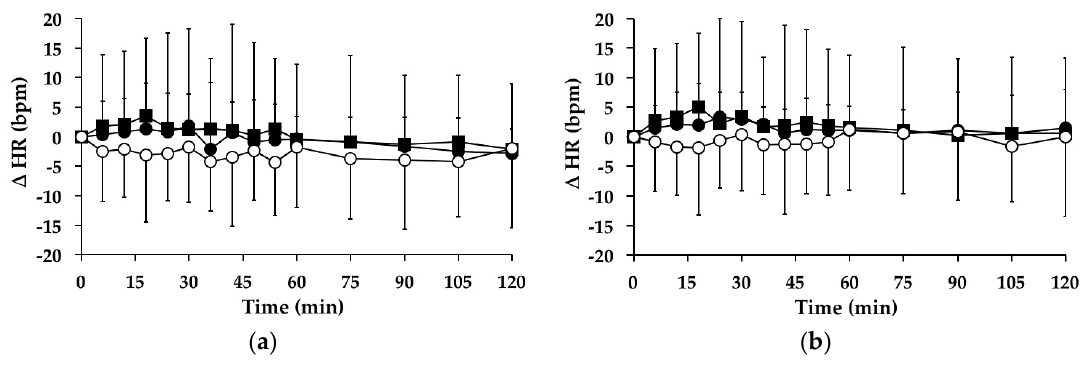
Figure 2. Mean change ( ) in heart rate (HR) on “G” ( ), “WW” ( ) and “GW” ( ) days in subjects: ( a ) with postprandial hypotension (PPH); and ( b ) without PPH. Data are mean ± standard deviation (SD) represented by vertical bars.